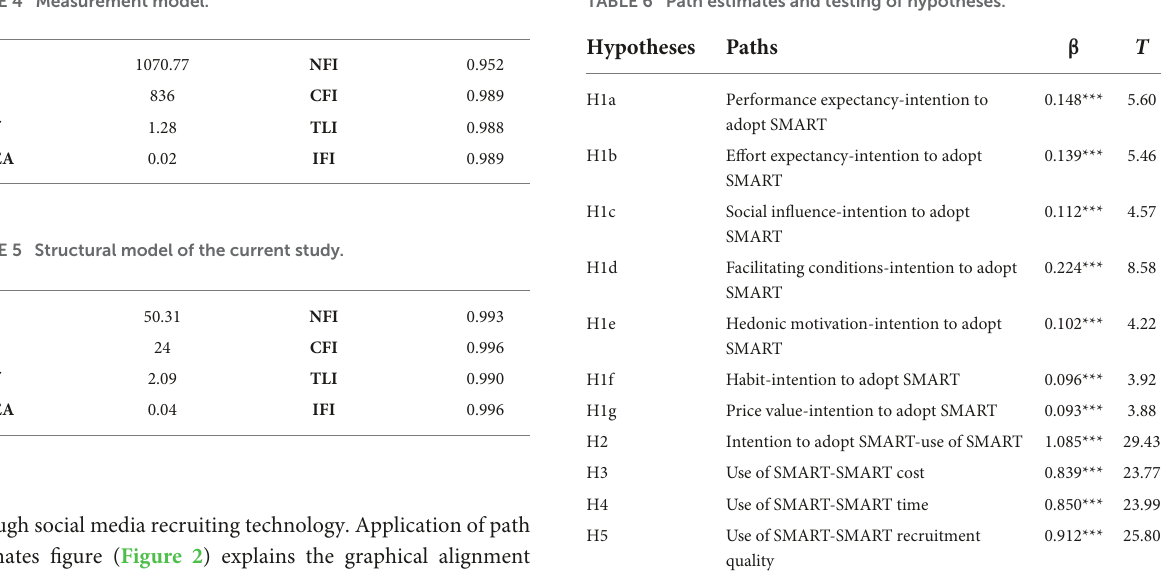
TABLE 4 Measurement model.